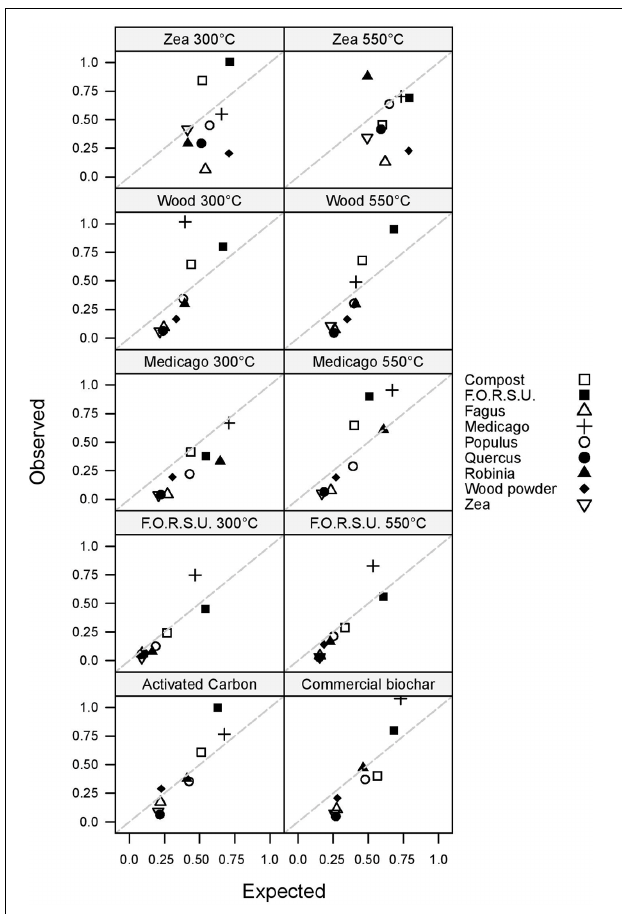
FIGURE 3 | Observed vs. expected values of lettuce growth in mixtures composed of not pyrogenic organic amendment and biochar. Values above and below the 1:1 dashed line indicate synergistic and antagonistic interactions, respectively.